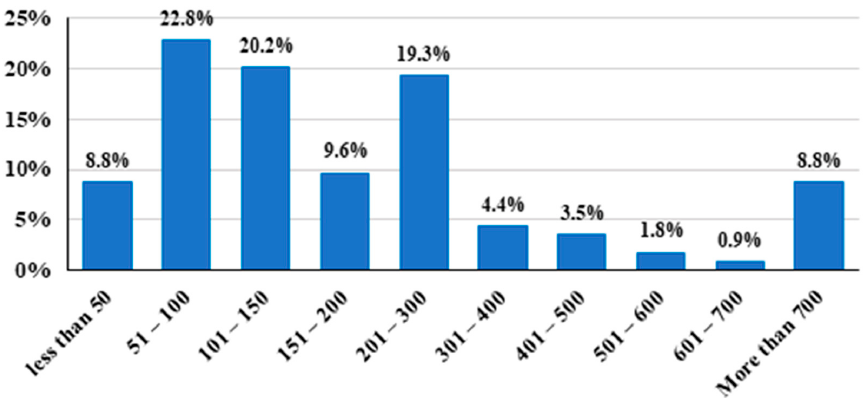
Figure 4. Number of soil samples used in the reviewed